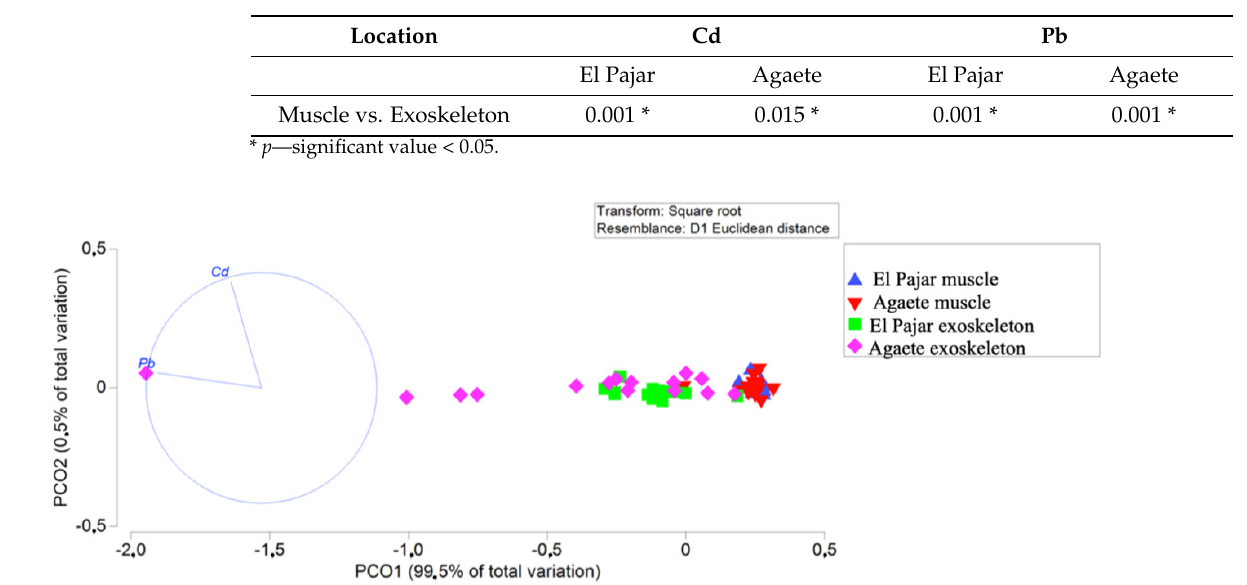
Table 5. PERMANOVA analysis of heavy metals in muscle tissue and exoskeleton with the location factor and type of sample.